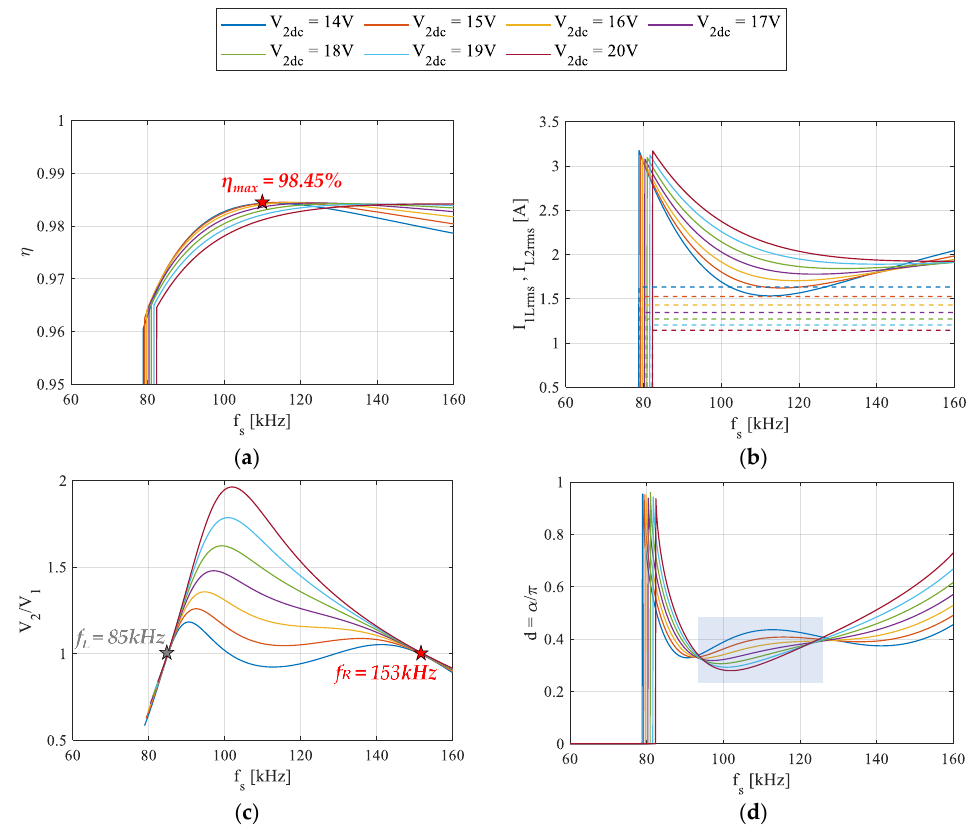
Figure 12. Predictions of IPTS modeling solution (5) – (8) vs. f s for different values of V 2 dc , for the capacitor set-up { C 1 = 100 nF, C 2 = 100 nF}: ( a ) IPTS efficiency η ; ( b ) TX and RX coil rms currents I L 1rms (solid), I L 2rms (dashed); ( c ) IPTS RX-to-TX voltage gain V 2 / V 1 ; and ( d ) normalized phase-shift d .